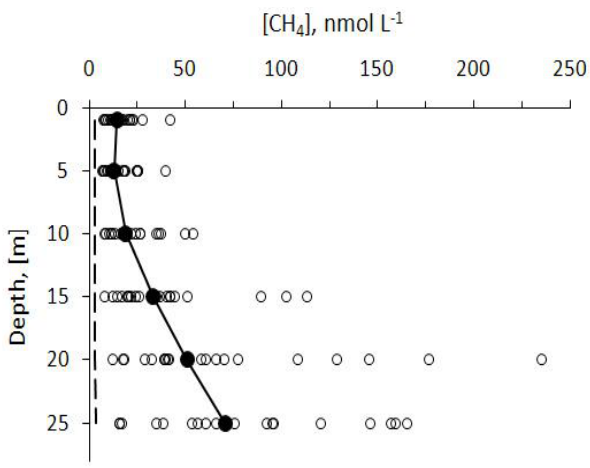
depth. The dashed line indicates the corresponding CH 4 equilibrium concentrations.